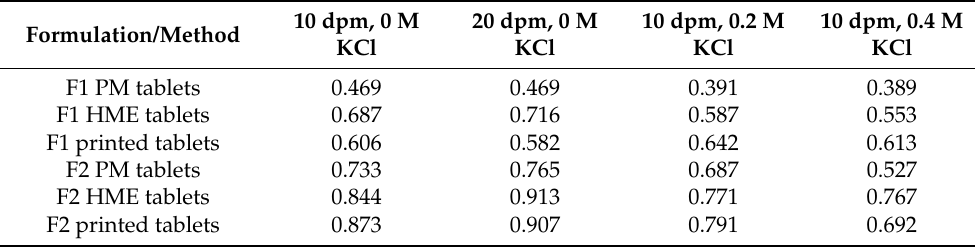
Table 6. The Korsmeyer–Peppas n values for drug release from F1 and F2 tablets under different dissolution conditions of dipping rate (10 or 20 dpm) and added KCl